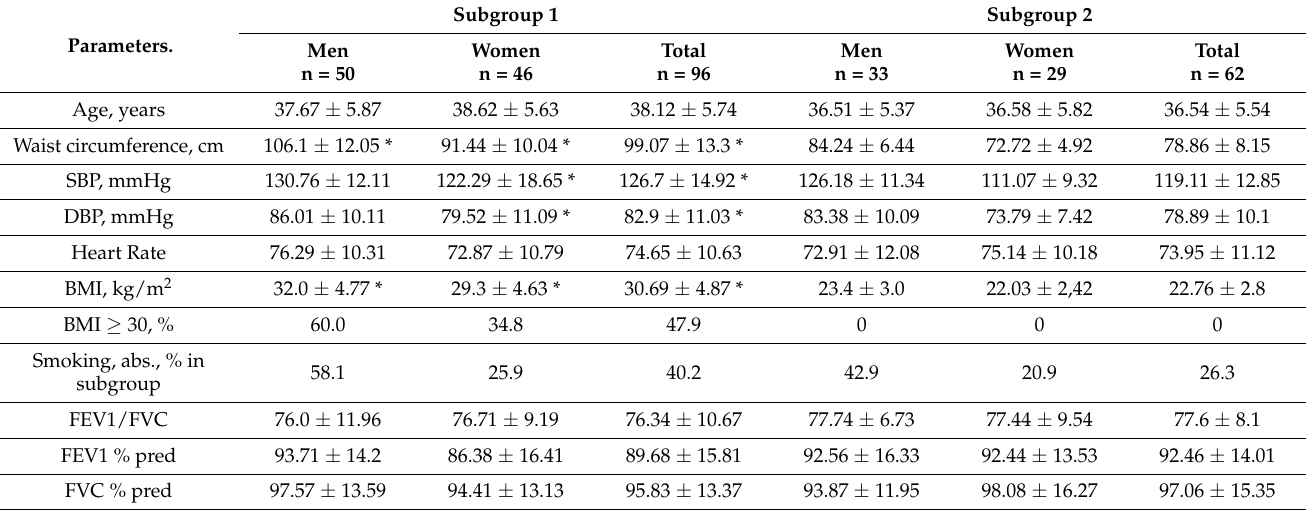
Table 2. Clinical and anamnestic data of patients in the first and second subgroups (M ± SD).